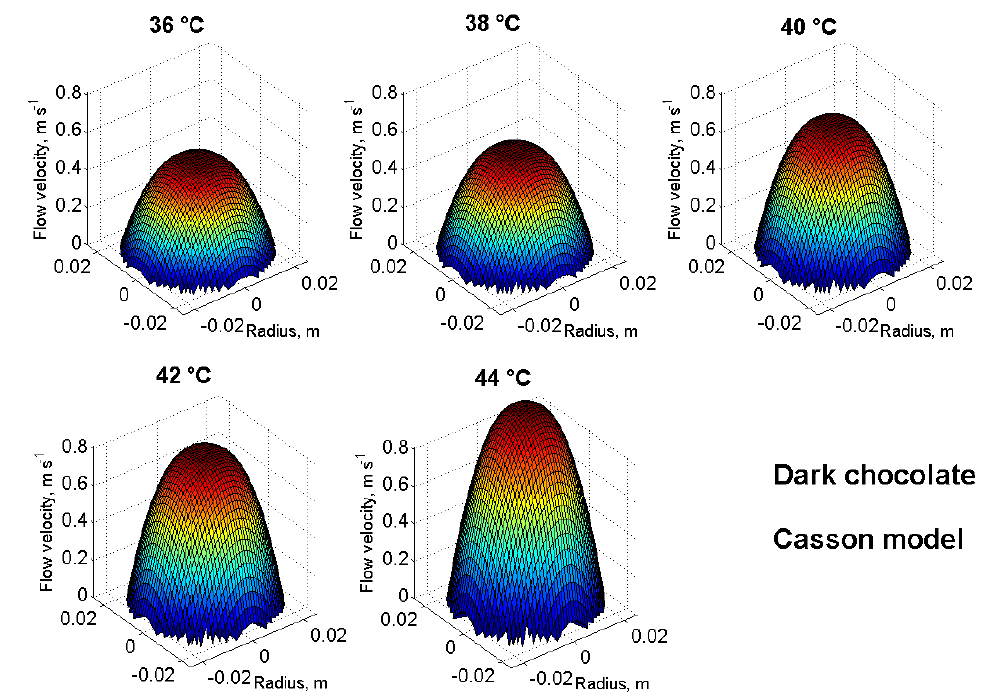
Figure 5. 3D velocity profiles at 36–44 ◦ C of DC using the Casson